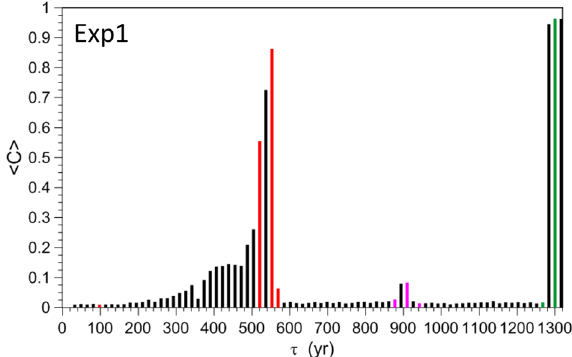
Figure 7. Dependence of the number ¯ C of trajectory clusters on τ for Exp1, with T 0 = 50 year and r = 0.5 in Eq. (6). The magenta, green and red bars refer to the ESs shown in Supplementary Figures S5, S6 and S8,